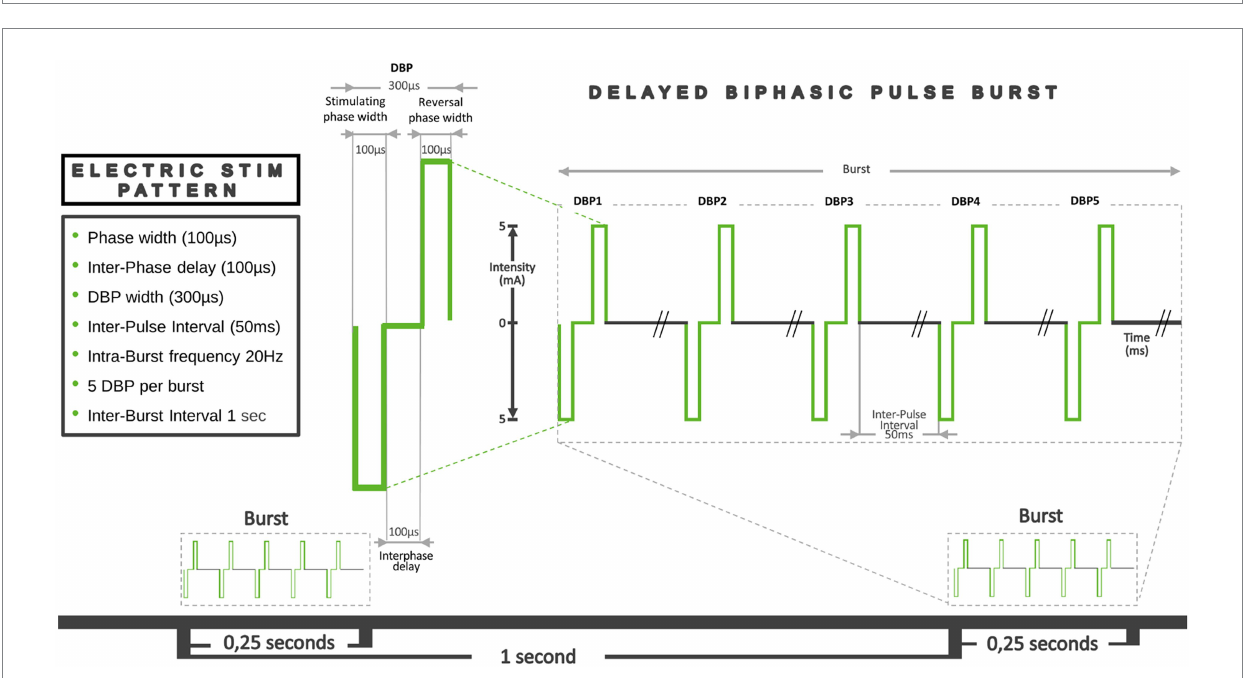
FIGURE 2 Graphical representation of the main parameters of the DBP-type burst pacing pattern. Pulse width: the duration of a single electrical pulse. In this case, we used Delayed Biphasic Pulse (DBP), which consisted of three consecutive distinct periods: an initial 100 μ s stimulation period, an intermediate 100 μ s interphase delay phase and a final reversal phase 100 μ s stimulation period. So, a total DBP duration was 300 μ s. The time between each of these pulses or Inter-Pulse Interval (IPI) was 50 ms. The number of pulses in a train, their duration and the IPI determined the intra-train frequency (20 Hz). Total duration of each train was 0.2515 s. Thus, 5 pulses were applied every quarter of a second, which means a frequency of around 20 Hz. The Inter- Burst Interval (IBI) defined as the time that passes between one train and the next, was 1